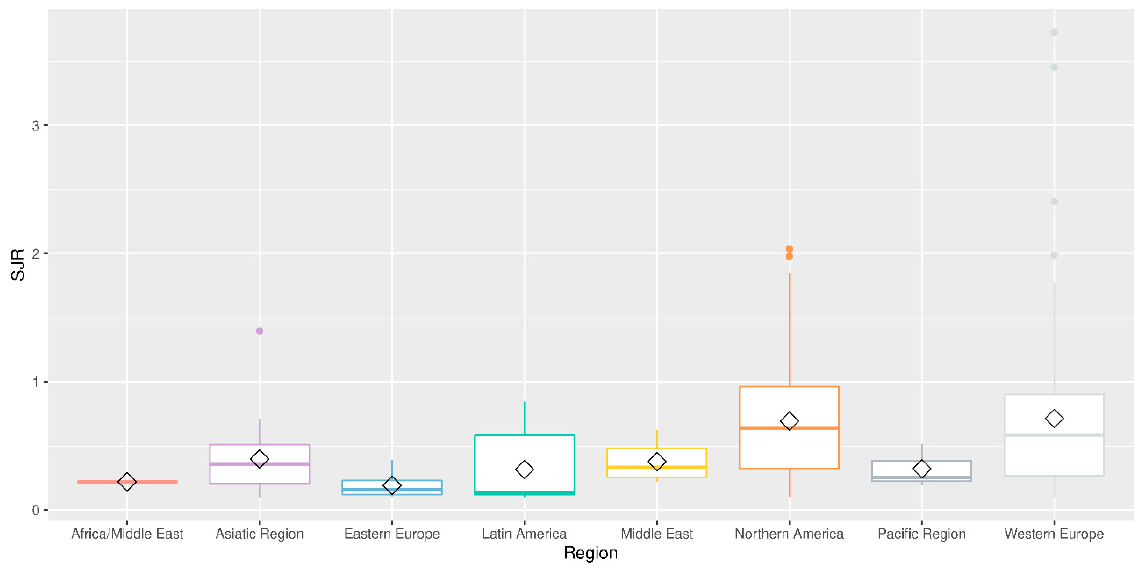
Figure 6. Global comparison of SJR between all regions.